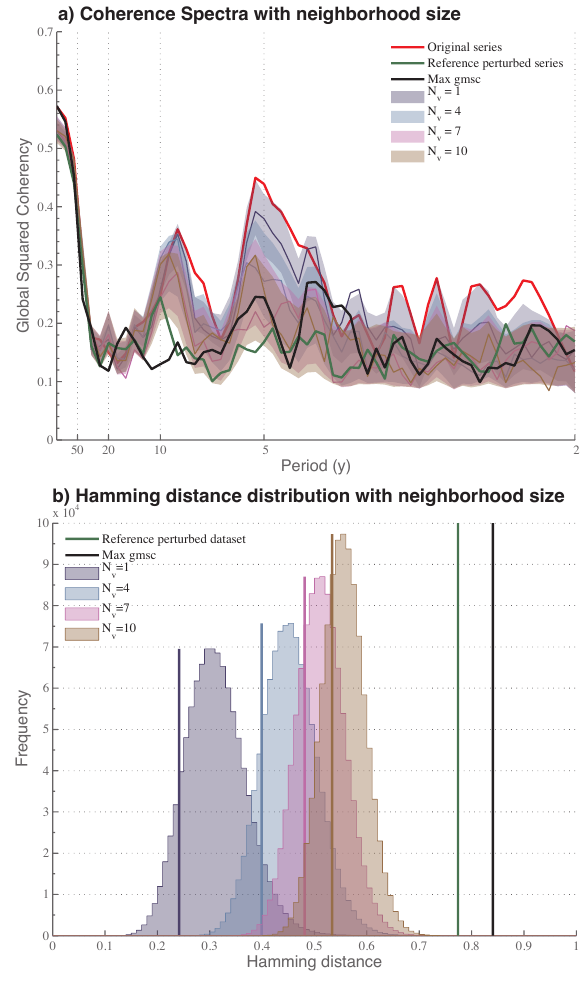
Fig. 8. Coherence spectra (top) and Hamming distance distributions to the original chronology (bottom) for ensembles of chronologies sampled around the reference perturbation matrix (with θ = 0 . 05), in restricted neighborhood of sizes 2 ∗ N v + 1 for N v increasing from 1 to 10. The thick red curve represents the coherence spec- trum for the error-free data, the results related to the reference per- turbed data set are shown in green, and plotted in black are the re- sults for the ensemble realization (sampled across the entire solution space) that maximizes the GMSC for the neighborhood ensembles (shaded areas): the 95% CIs and Hamming distance distributions, and corresponding realizations maximizing the GMSC (solid lines) are shown in dark blue, blue, pink and light brown for N v = 1, 4, 7 and 10,